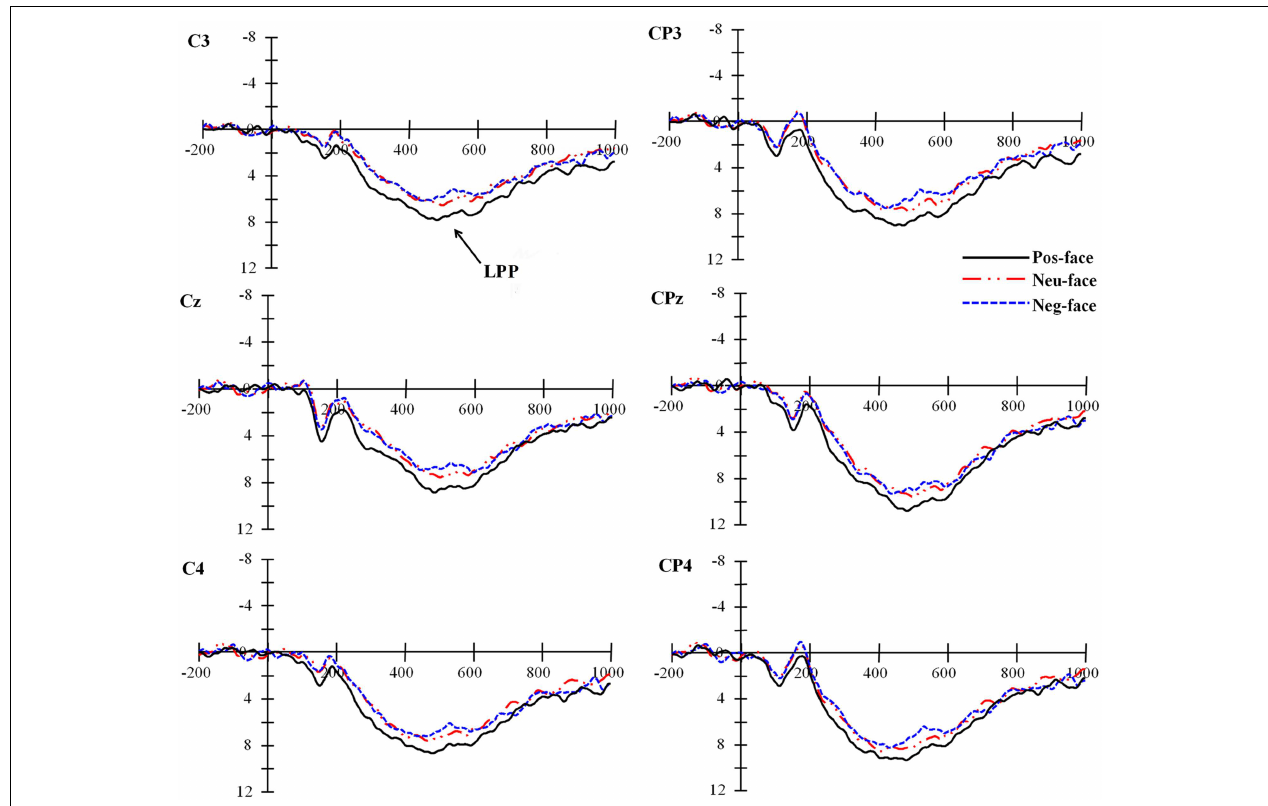
FIGURE 4 | Grand averages at parietal sites for faces of varying